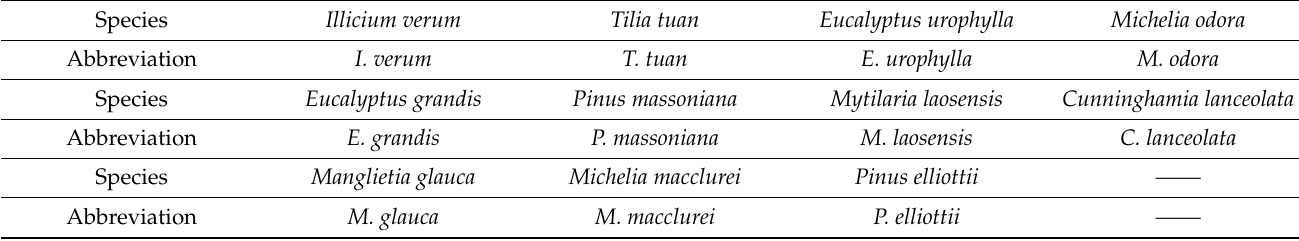
Table 2. Abbreviations of tree